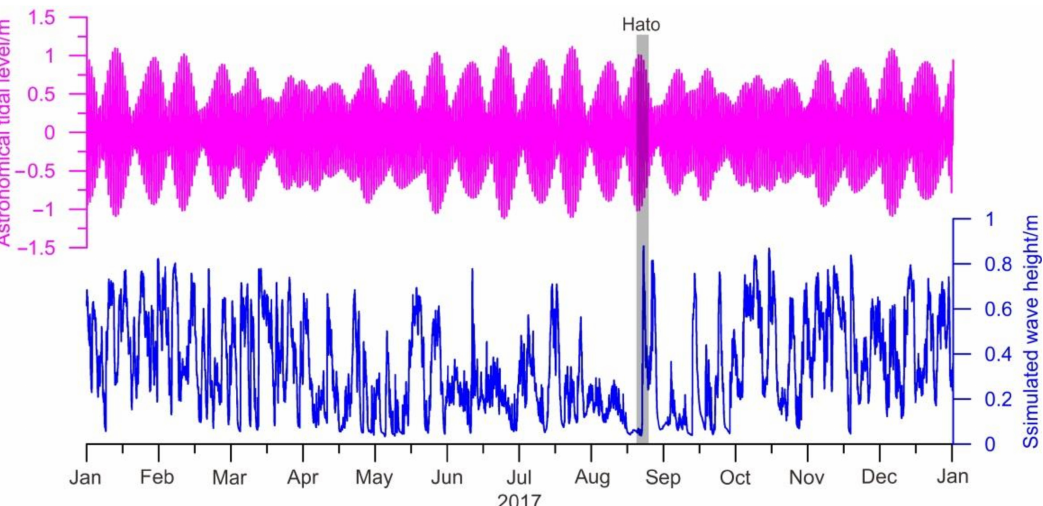
Figure 4. Derived astronomical tidal levels ( upper panel ) and simulated wave heights ( lower panel ) near ML beach during 2017. Grey band highlights the period in which Typhoon Hato approached.